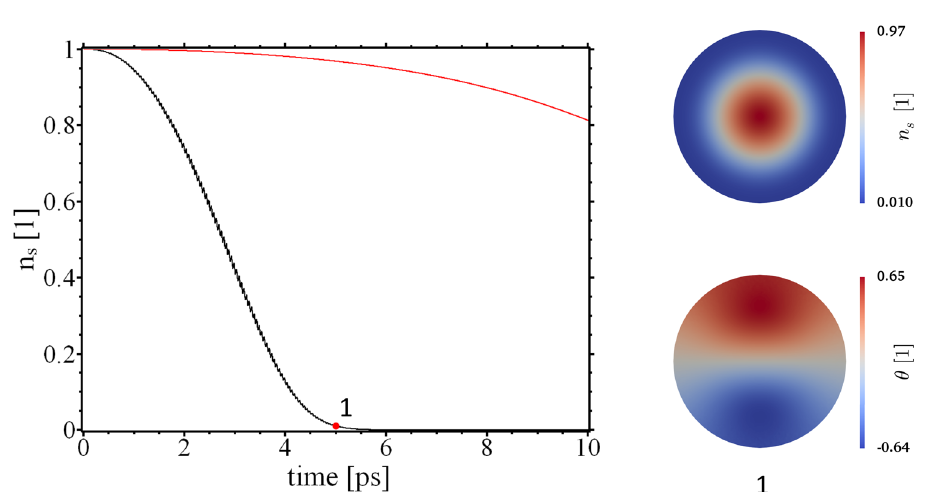
0, t 1.5 ps of the total current density ( a ), and of the = = 0 . =